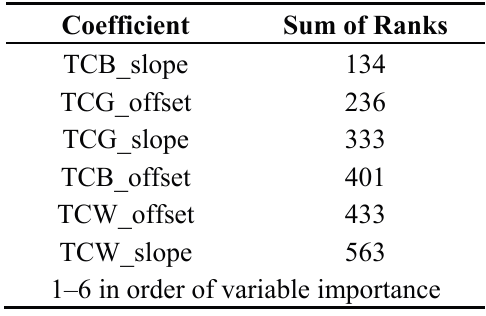
Table 7. Sum of ranks of variable importance over 100 decision tree model